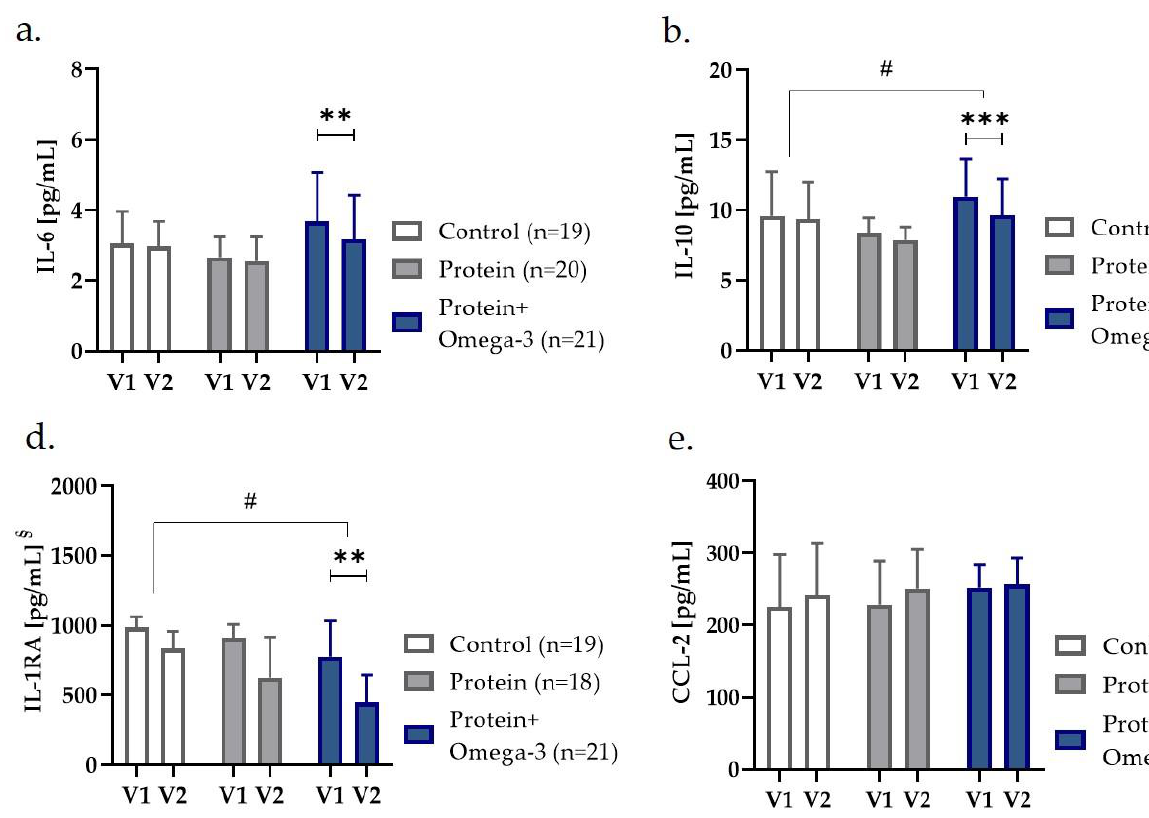
Figure 1. Fasting serum concentrations of ( a ) IL-6, ( b ) IL-10, ( c ) IL-6/IL-10 ratio, ( d ) IL-1RA, ( e ) CCL-2, and ( f ) HMGB-1 presented as estimated mean with 95% confidence interval before (V1) and after (V2) eight weeks of control, high-protein (protein) or high-protein, omega-3-enriched (protein + omega-3) diet. ** p < 0.01, *** p < 0.001 obtained from within-group comparisons with either paired t -test or Wilcoxon rank test, and # p < 0.05 indicating group × time-interaction effects between groups in generalized linear mixed models with random effects on subjects, adjusted for age, sex, and fat mass index, § and due to significantly different cases at baseline, also adjusted for baseline values. CCL-2 c-c motif chemokine ligand-2; HMGB-1 high-mobility group box-1; IL interleukin, RA receptor antagonist.